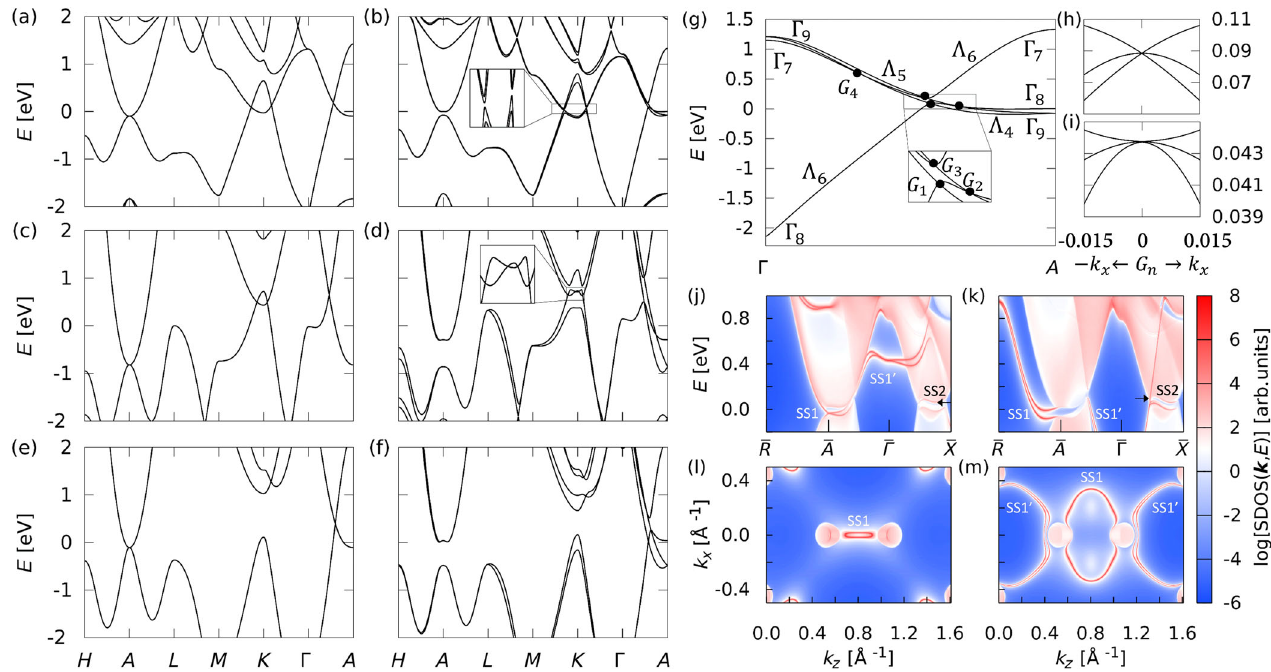
FIG. 4. Band structure of ZrTe (a) [(b)], WC (c) [(d)], and TaN (e) [(f)] without [with] SOC. The Fermi energy is set to 0 eV. (g) Band structure of ZrTe along the Γ - A line. Bands are labeled by their double group representations corresponding to D 3 C 3 on the Γ - A line. (h) [(i)] Band structures in the (100) direction with k v states (SDOS) for the (010) surface of ZrTe with Zr [Te] termination. (l) [(m)] The (010)-surface Fermi surface of ZrTe at E ¼ 0 eV for Zr [Te]